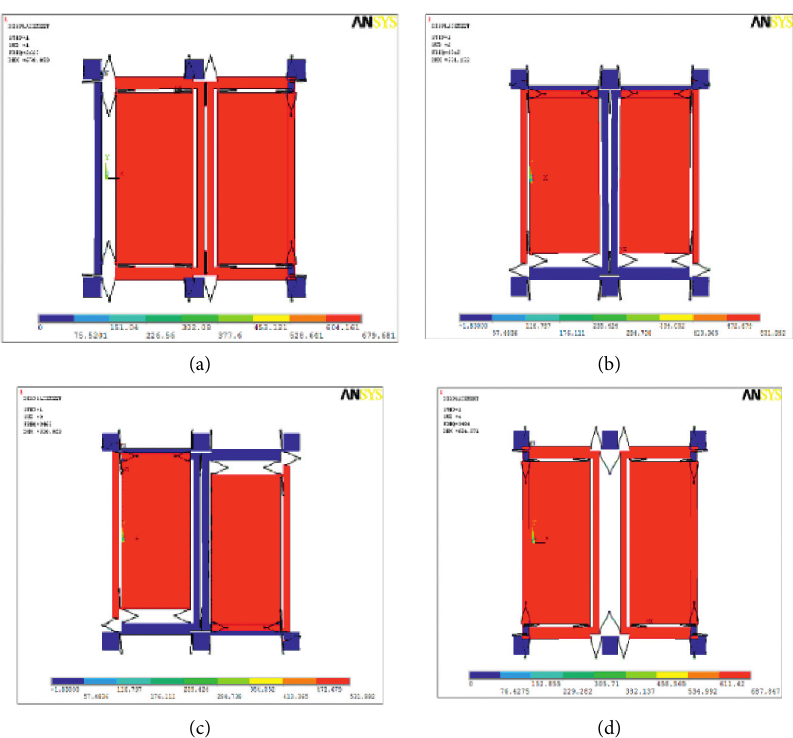
Figure 2: First four modes: (a) drive in phase mode (first mode) with frequency ωx 1 � 2623 × 2rad/s; (b) sensing in phase mode (second mode) with frequency ωy 1 � 3342 × 2rad/s; (c) sensing in anti-phase mode (third mode) with frequency ωy 2 � 3468 × 2 rad/s; (d) drive in anti-phase mode (fourth mode) with frequency ωx 2 � 3484 × 2 π